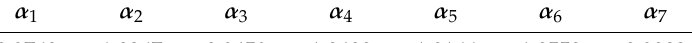
Figure 16. Geometry of cruciform specimen.